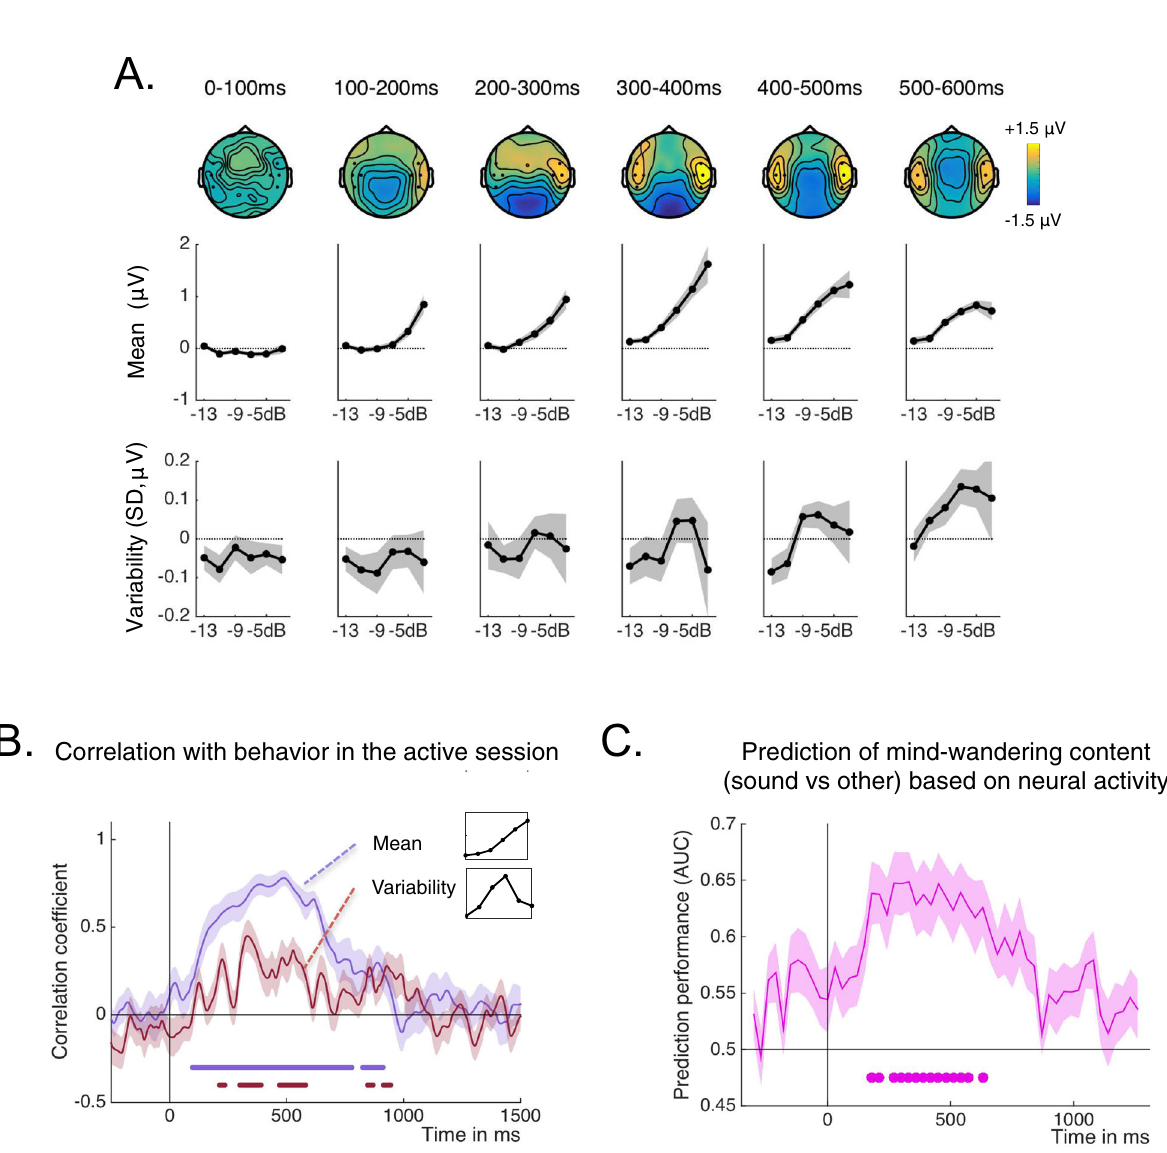
Fig. 5 Neural dynamics for passive sessions. A The top row shows the group averaged topographies at different time windows following targets played at − 5 dB SNR. The middle and bottom rows show the mean and variability of evoked potentials as a function of SNR, for different time windows and over a group of temporal electrodes highlighted on the topographies. Shaded areas are SEMs ( n = 20 participants, from which 10 at − 3 dB). B Correlation coef fi cient between the individual mean pro fi les (blue) or variability pro fi les (red) of projected activity in the passive session with the individual mean pro fi les or variability pro fi les of behavioral audibility during the active session (shifted by 1 or 2 SNR levels). The shaded areas are SEMs ( n = 20 participants). Periods of signi fi cant correlation are denoted in thick lines of the corresponding color (one-sided t -tests, p < 0.05, FDR corrected). C Prediction of mind-wandering content from the neural projected activity under the assumption of bifurcation dynamics. The graph shows the group average performance in predicting, trial by trial, whether the participant responded that the sound was on their mind at the moment of the probe or not. All SNRs are included in this analysis. The shaded areas are SEMs ( n = 20 participants). Thick dots denote periods were prediction performance was better than chance (two-sided t -tests, p < 0.05, FDR corrected). Source data for this fi gure are provided as a Source data fi